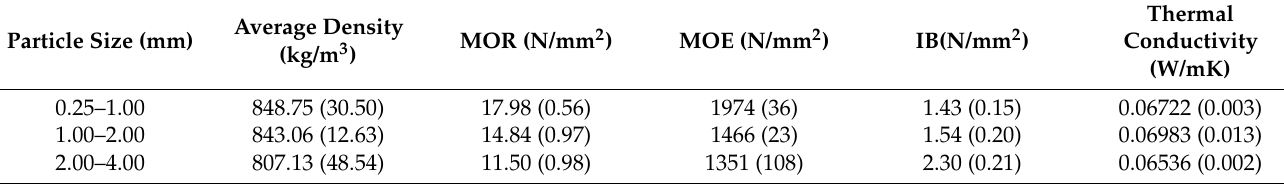
Table 3. Characteristics of the experimental panels.